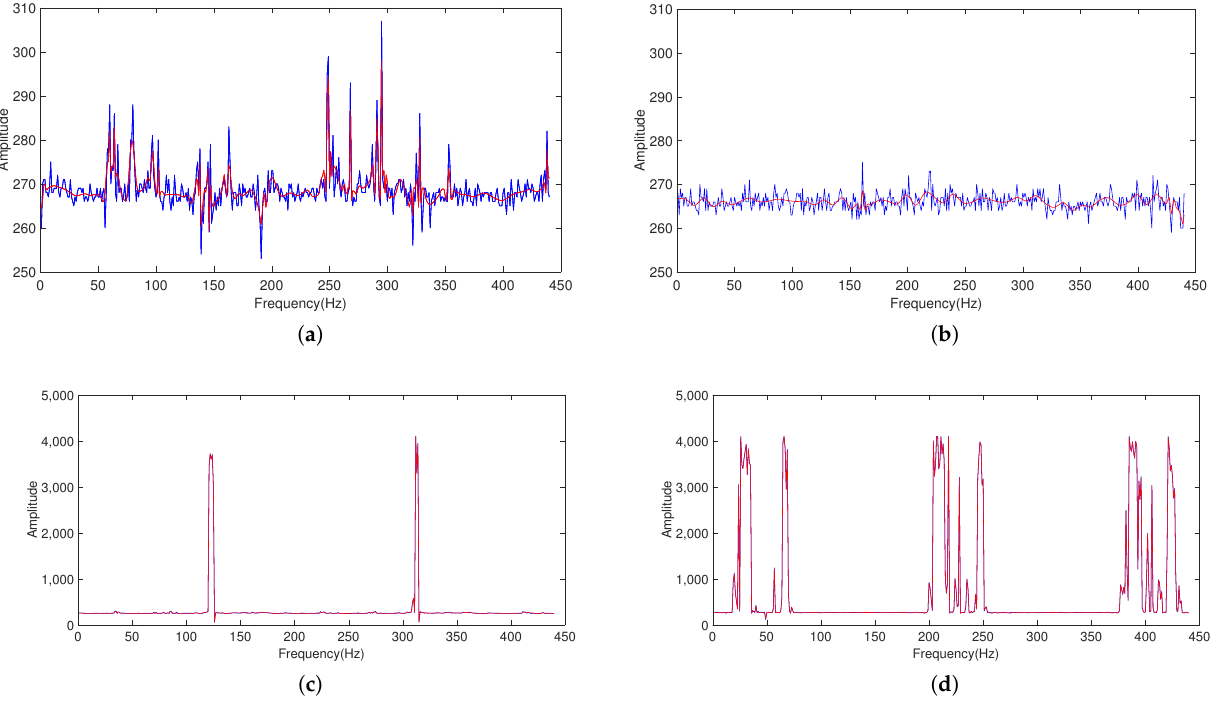
Figure 13. Egg current waveform. ( a , b ) Waveforms of intact eggs. ( c , d ) Waveforms of cracked eggs. After the wavelet threshold denoising, the time domain, frequency domain, and wavelet packet coefficients of the current signal were extracted. It can be seen from Figures 14 and 15 that most of the features of the intact eggs and cracked eggs had obvious differences, but some of the differences were not